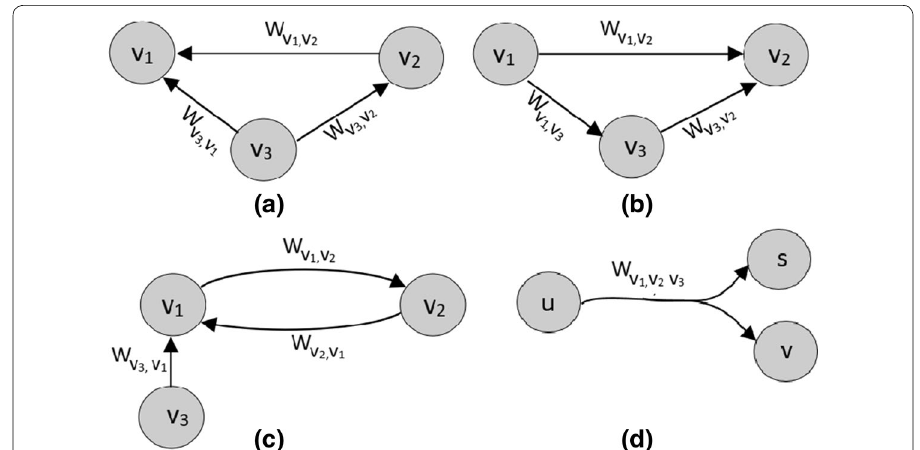
Fig. 3 Various types of graphs: a undirected graph; b directed graph; c multi-graph; d